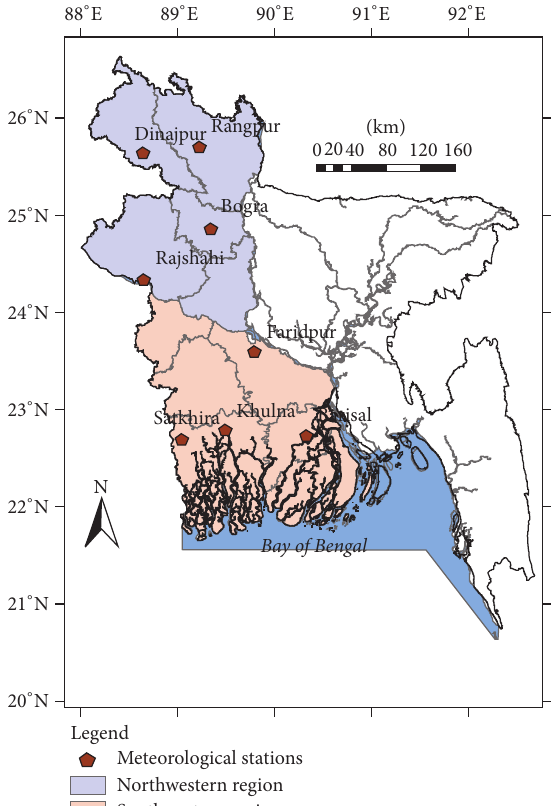
Figure 1: The location map showing meteorological stations and the extent of the northwestern and southwestern regions in western